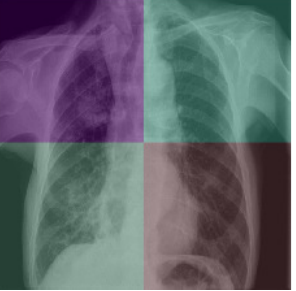
Figure 8. xRGM-Version 1 Heat-Map. X-ray from